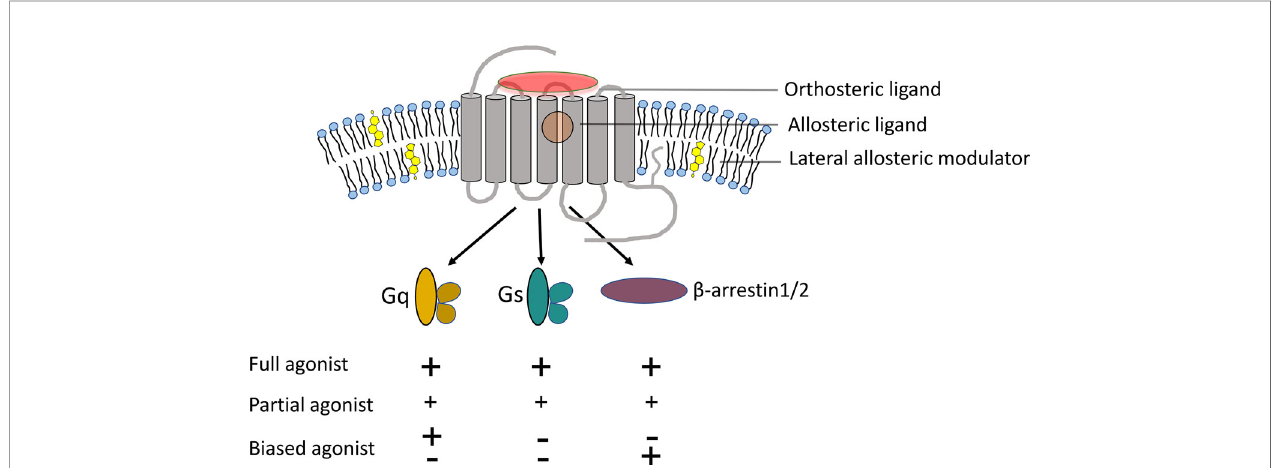
FIGURE 1 | Potential for new types of CCK1R-active drugs. Shown is a diagram of a GPCR, highlighting the orthosteric site of action of the natural agonist ligand and distinct allosteric sites of action for allosteric modulators. These can be lateral allosteric modulation through membrane lipids like cholesterol or through association with other membrane proteins, or via ligands that bind to the receptor in places outside of the orthosteric site. Any of these ligands can act as full agonists, stimulating the full range of pleiotropic signaling events activated by the natural agonist, or reduced responses of some of these events (partial agonist and biased agonists). Traditional drug development has focused on full agonists and antagonists (inverse agonists). It is now clear that “ texture ” in responses can be evoked by allosteric modulation and/or biased